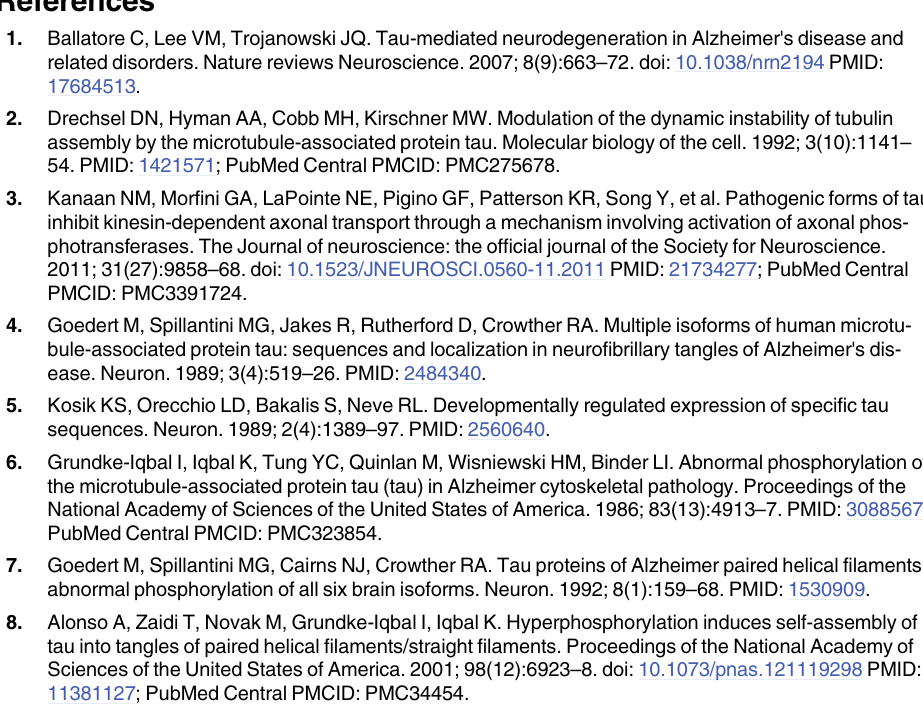
S1 Table. Information on AD brain and control brain donors. Donor information of AD and control brain extracts that have been used to validate our AlphaLISA assays. This table is related with Fig 2 of the main